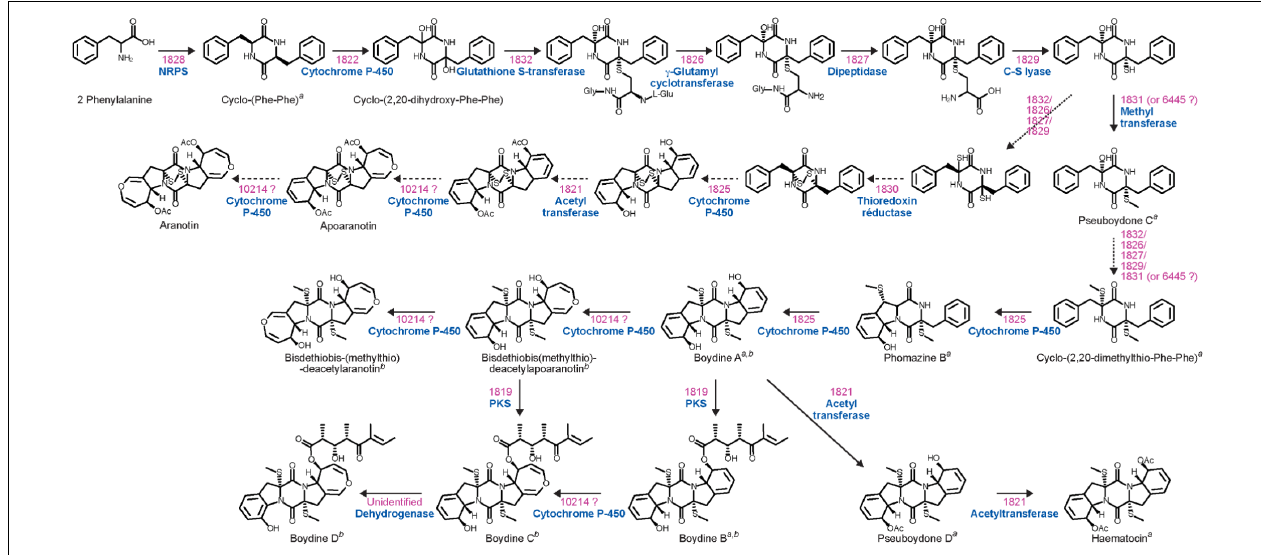
FIGURE 4 | Proposed biosynthetic pathway for acetylaranotin and boydin derivatives. For each step, the genes involved as well as their putative function are depicted in pink and blue, respectively. The gene SAPIO_CDS6445, located outside of ETP1828 gene cluster, corresponds to the best hit against gtmA/tmtA and ataS , the major bis-thiomethyltransferase genes responsible for catalyzing the S -methylation step leading to the inactivation of gliotoxin and acetylaranotin compounds, respectively (Dolan et al., 2014; Scharf et al., 2014; Sun et al., 2018). The CDS10214 denotes an unclustered gene coding for a benzoate para-hydroxylase cytochrome P450 potentially responsible for the formation of the dihydrooxepin moiety that converts (i) a diacetate intermediate to aranotin via apoaranotin, (ii) boydin A to bisdethiobis-(methylthio)-deacetylaranotin via bisdethiobis(methylthio)-deacetylapoaranotin, and (iii) boydin B to boydin C. The superscript letters a and b indicate the natural products isolated from S. boydii by Lan et al. (2016) and Wu et al. (2014),